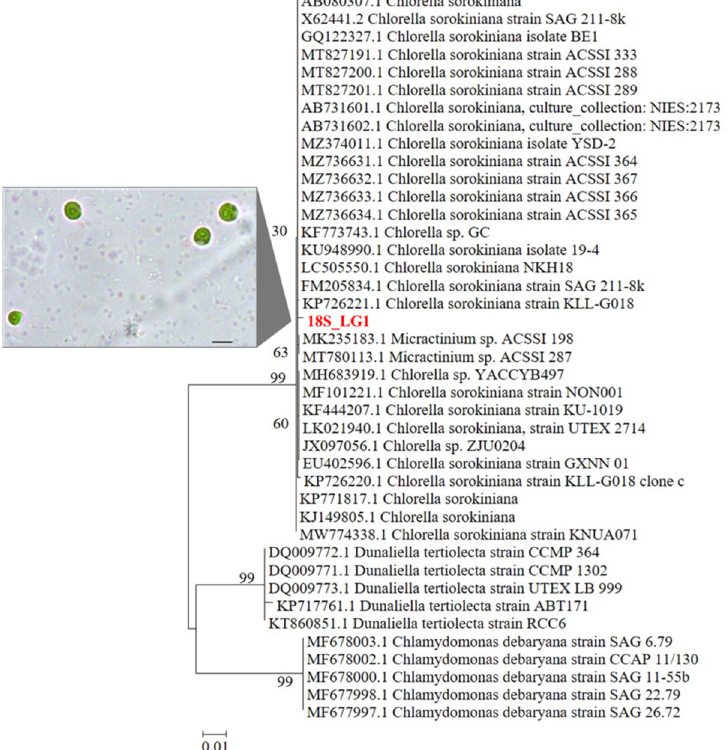
Figure 1. Phylogenetic tree reconstruction obtained with the Maximum Likelihood method on a total of 41 high quality sequences selected from the most similar to the sequences obtained for the LG1 strain. Inset: optical microscope image of LG1 cells (scale bar: 5 μ m).